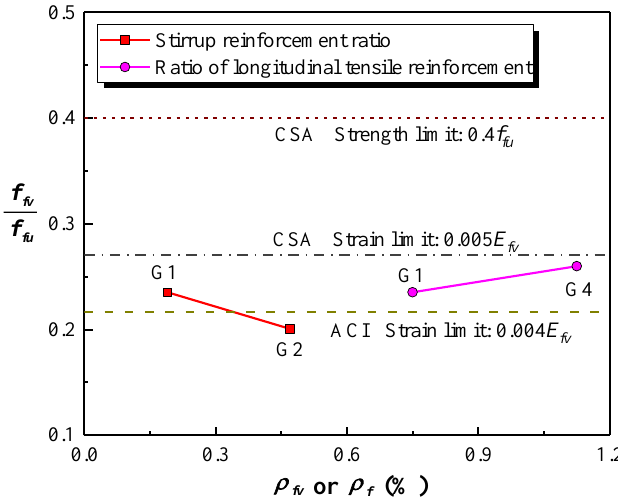
Figure 23. The effective stress of the spiral stirrups.